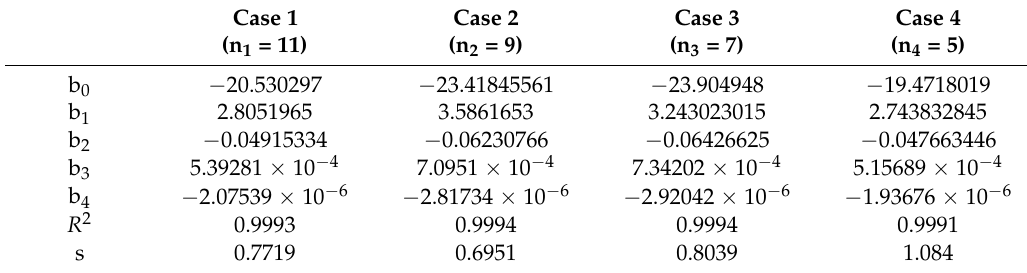
Table 6. Estimated parameters and evaluation criteria for the 4th order polynomial equations for THT-B121 resistive sensors using four different calibration